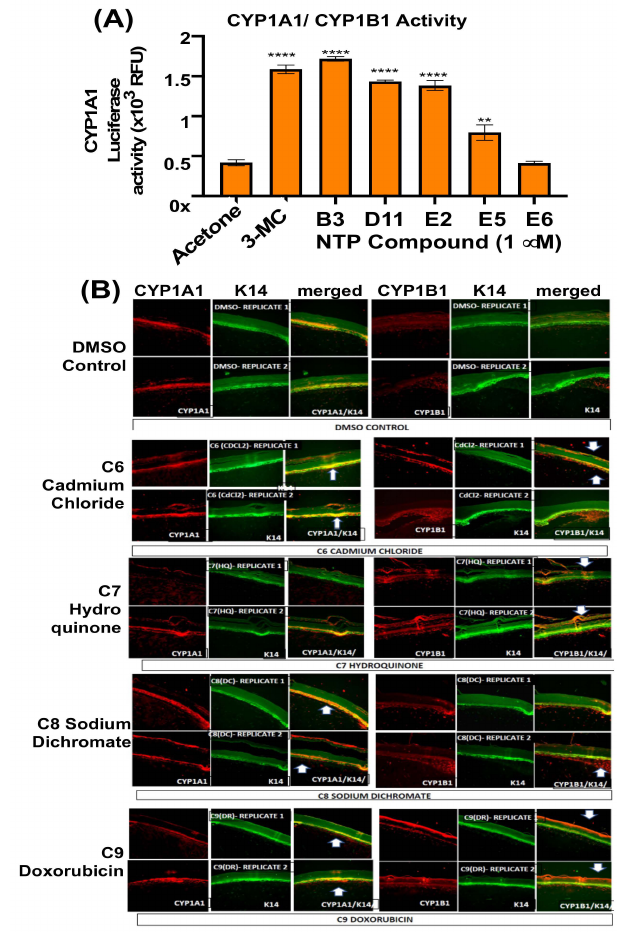
Figure 8. CYP activity ( A ) and expression ( B ) in EpiDerm skin equivalents after NTP compound treatment. EpiDerm was exposed to the indicated compounds, and 5 µ m sections were derived and incubated using antibody specific for CYP1A1 or CYP1B1, followed by Alexa 488-conjugated or Alexa 594 conjugated secondary antibodies, as described in Materials and Methods. Equal exposures were captured by microscopy for a comparison of CYP expression levels. **, and **** represent p values < 0.01, and 0.0001,